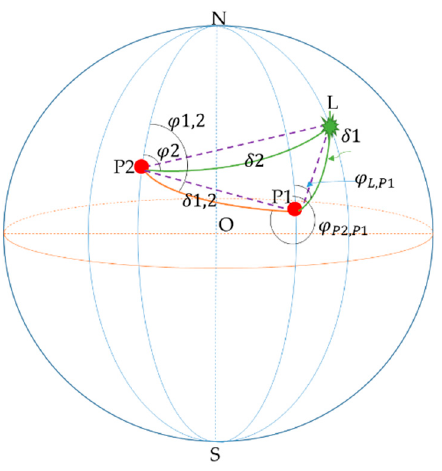
Figure 7. Schematic diagram of the location method using spherical triangle. Lightning L traveled along the solid green line to sites P1 and P2. O is the center of the ball. N is the North Pole and S is the South Pole.